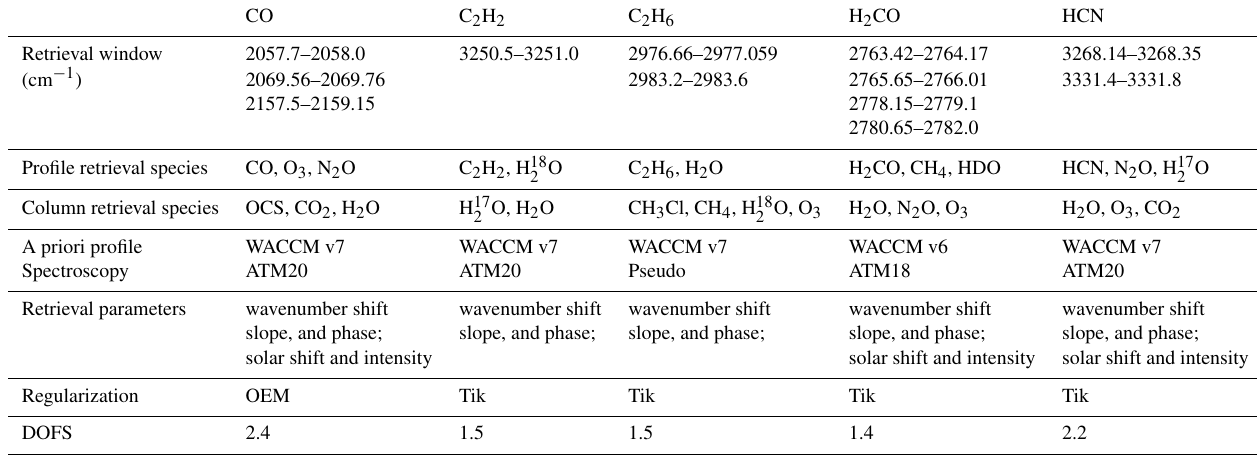
Table 3. The retrieval window, interfering species, spectroscopy, and fitting parameters for these five species. Note that the isotopes of H 2 O (HDO, H 17 O, and H 18 O) are treated as independent species in our retrieval. 2 2 CO C 2 H 2 C 2 H 6 H 2 CO